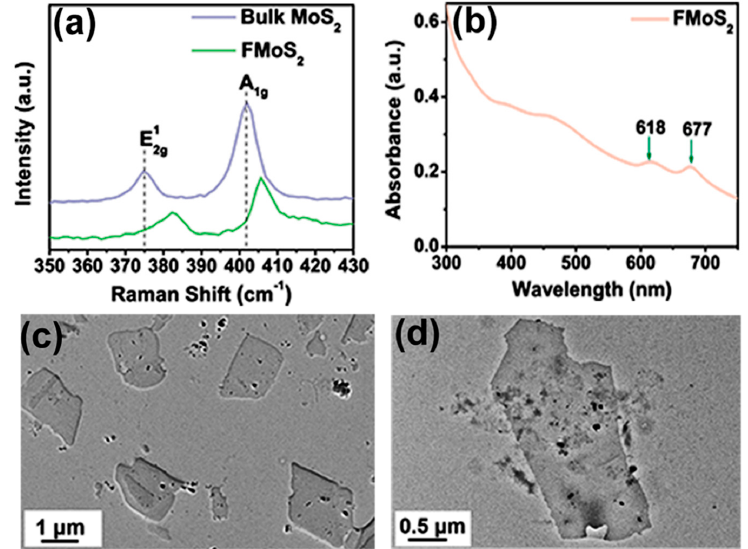
Figure 2. ( a ) Raman spectra of bulk and oleylamine-functionalized MoS 2 (FMoS 2 ). ( b ) Ultraviolet– visible light absorption spectrum of FMoS 2 . ( c , d ) Transmission electron microscopy images of FMoS 2